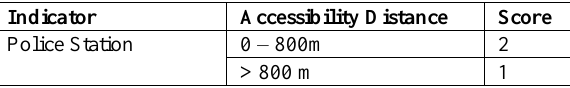
Table 6: The radius distance accessibility between residential housing and safety